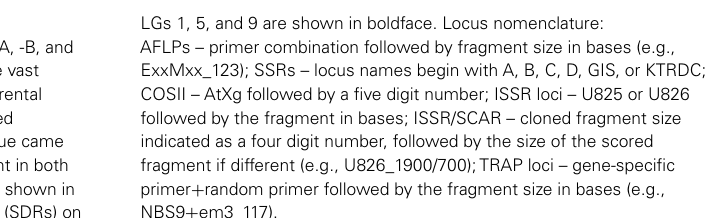
FIGURE 1 | Molecular marker linkage map of the Nicotiana langsdorffii genome. The 12 linkage groups (LGs 1–9 plus LG-A, -B, and -C) together comprise a recombinational length of 1062cM.The vast majority of the markers were present in only one of the two parental inbred lines used in the segregation studies. Loci indicated in red originated in S-4-1 (susceptible to P. tabacina ), while those in blue came from S-4-4 (resistant to P. tabacina ). Markers with alleles present in both S-4-1 and S-4-4 are shown in black.The R-gene locus, NlRPT , is shown in green. Locus names in the three segregation distortion regions (SDRs) on